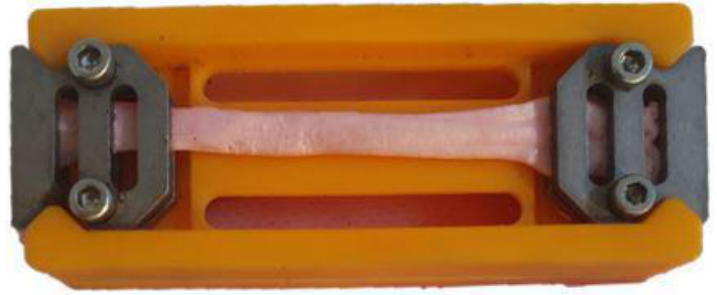
Figure 3. Holder for fixing tendons in the